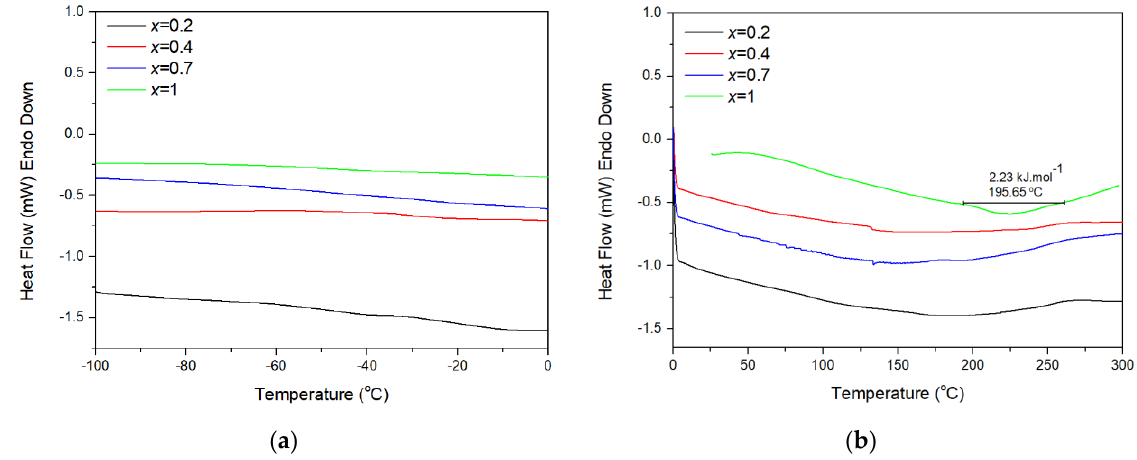
Figure 5. DSC curves for the x = 0.2, 0.4, 0.7 and 1 compositions in the family of Al 2− x In x W 3 O 12 at different temperatures: ( a ) cryogenic temperatures: ( b ) ambient and high temperatures. For x = 1, the onset temperature of the monoclinic-to- orthorhombic phase transition and the enthalpy of phase transition are presented as well.